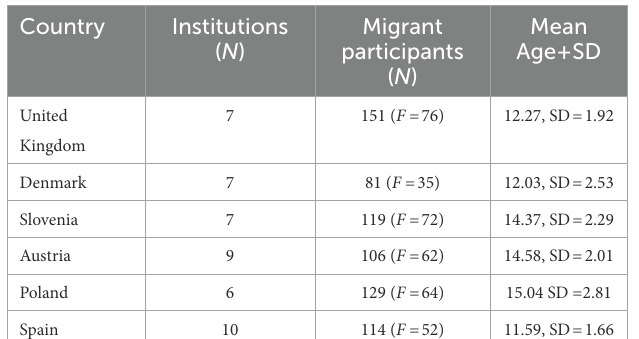
TABLE 1 Sample characteristics. TABLE 2 Pattern matrix for classmates’ and teachers’ relationship.